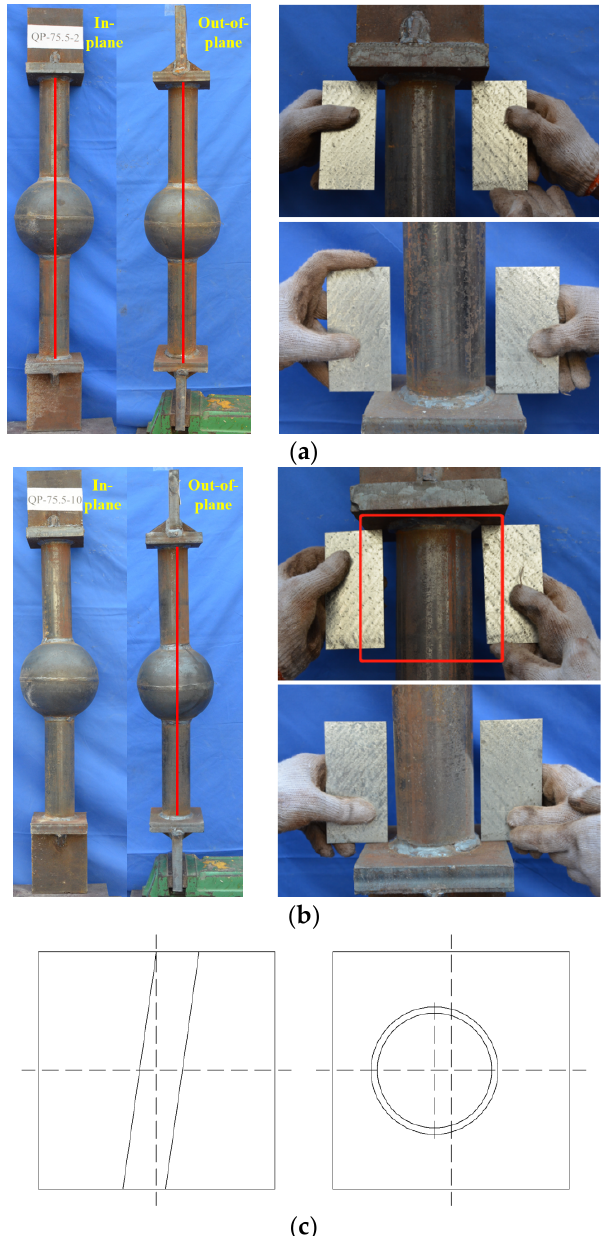
Figure 7. Coaxiality of specimen. ( a ) Tube ball basically centered, with endplate basically vertical. ( b ) Tube not centered and endplate not vertical. ( c ) Deviation of centroid of endplate and branch pipe.